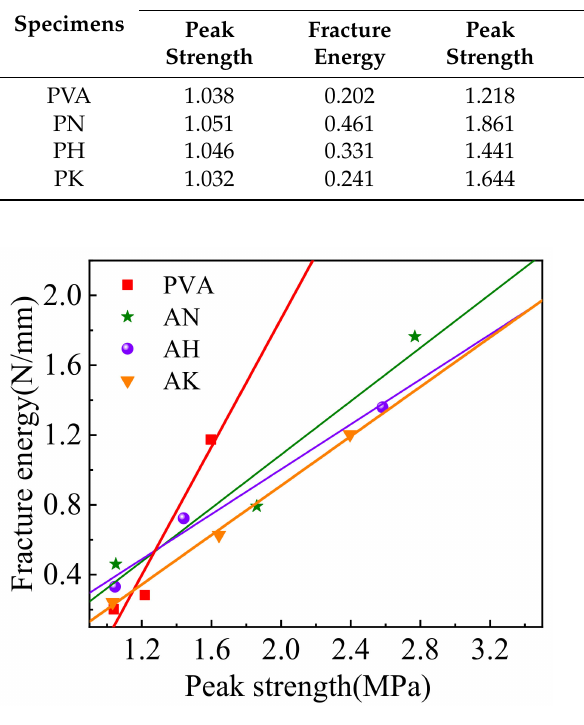
Figure 11. Relationship between fracture energy and peak strength. Table 8. Fitting parameters of PVA